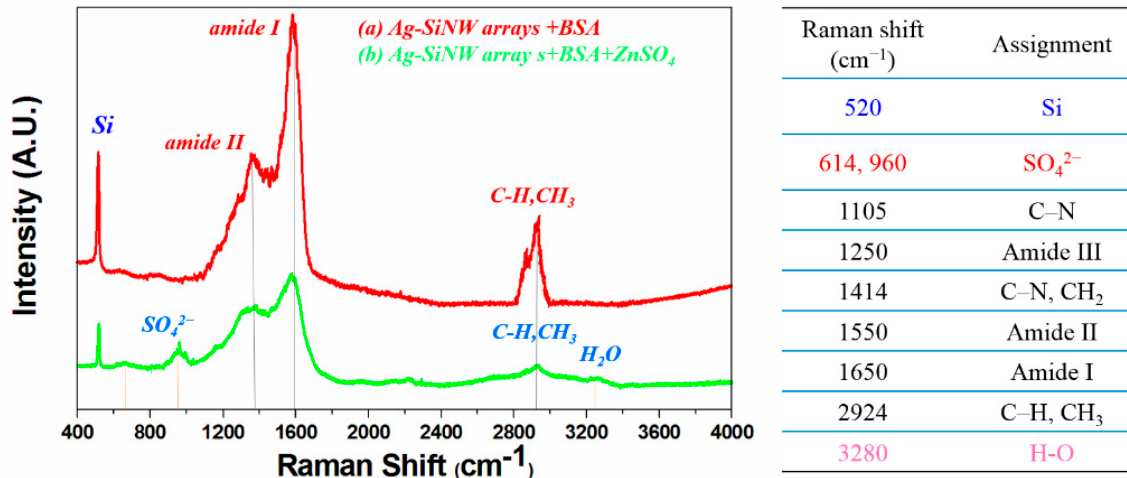
Figure 11. Comparison of SERS spectra of BSA immobilized onto ( a ) Ag–SiNW arrays (red line) and ( b ) SiNW arrays (black line). 3.4. SERS Mechanism for the Detection of Heavy Metal Ions Raman spectroscopy relies on inelastic scattering or Raman scattering of monochro- matic lights, usually excited from a laser in the visible, near infrared, or near ultraviolet range. The laser lights interacting with phonons result in shifting the patterns of the pho- tons, which gives the information of the modes. The Raman effects occur when light im- pinges upon a molecule and interacts with the molecular bonds of the electron clouds. This incident photon excites one of the electrons into a virtual state. For the spontaneous Raman effects, the molecule will be excited from its ground state to a virtual energy state and relaxed to a vibrational excited state, which generates Stokes Raman scattering. If the molecule is already in an elevated vibrational energy state, the Raman scattering is then called anti-Stokes Raman scattering. In the current study, two major effects are involved in the enhancement of Raman signals: (1) electromagnetic effects associated with dipolar resonance occurring on the metal surface, and (2) chemical effects from the scattering process induced by chemical interaction between molecules and metal surfaces. For the mechanism, there are possibly